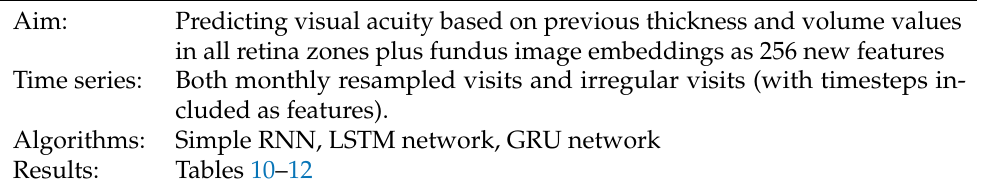
Table 5. Experiment 3 : Forecasting VA t + 1 from the numerical OCT features and fundus images.